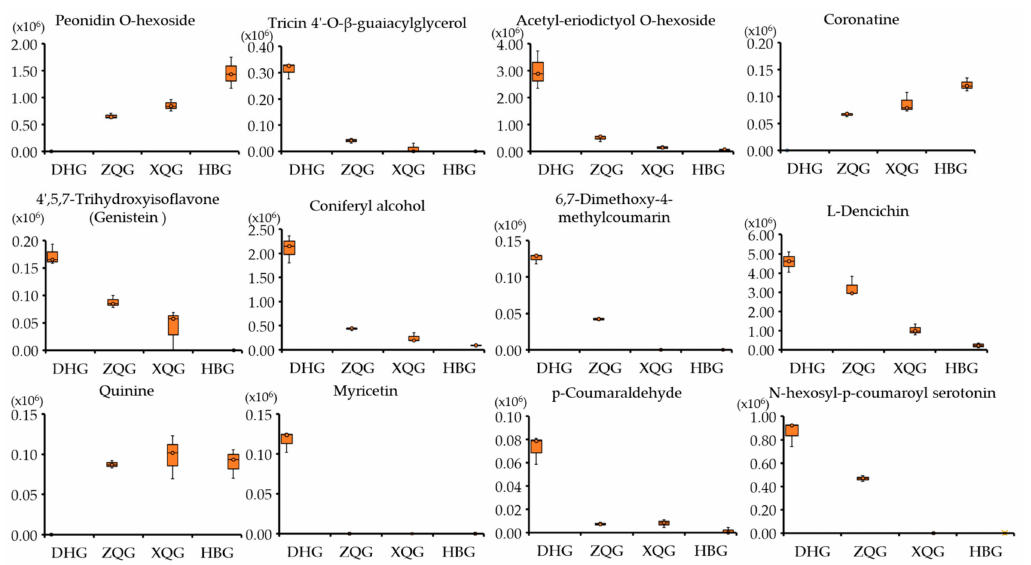
Figure 6. Boxplot of alkaloids, anthocyanins, phenylpropanoids, flavonoids, and other metabolites for the tree comparison groups. alkaloids: Quinine, l -Dencichin; Phenylpropanoids: Coniferyl alcohol, 6,7-Dimethoxy-4-methylcoumarin, p -Coumaraldehyde; Anthocyanins: peonidin O -hexoside; flavonoids: tricin 4 (cid:48) - O - β -guaiacylglycerol, acetyl-eriodictyol O -hexoside, myricetin, genistein (4 (cid:48) ,5,7-Trihydroxyisoflavone); other metabolites: N -hexosyl- p -coumaroyl serotonin and